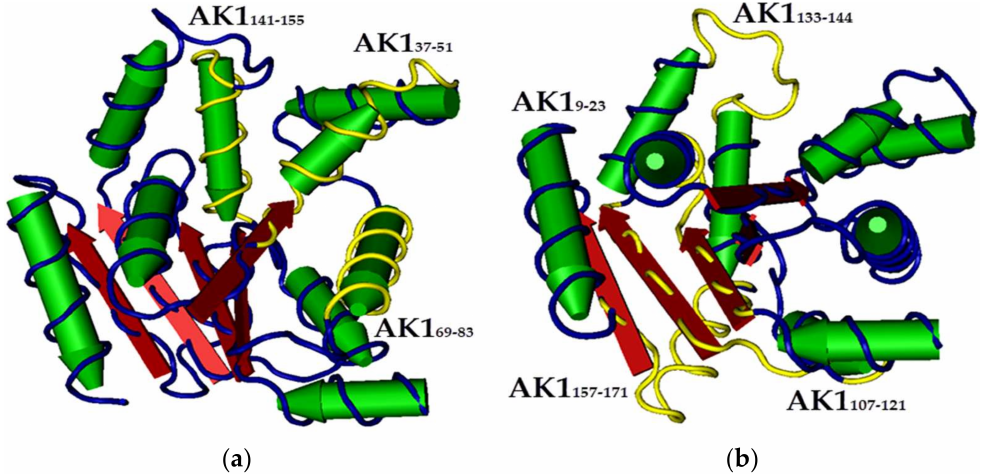
Figure 2. The structure of adenylate kinase 1. ( a ) α -helixes; ( b ) β -sheets and random coil. Yellow: selected